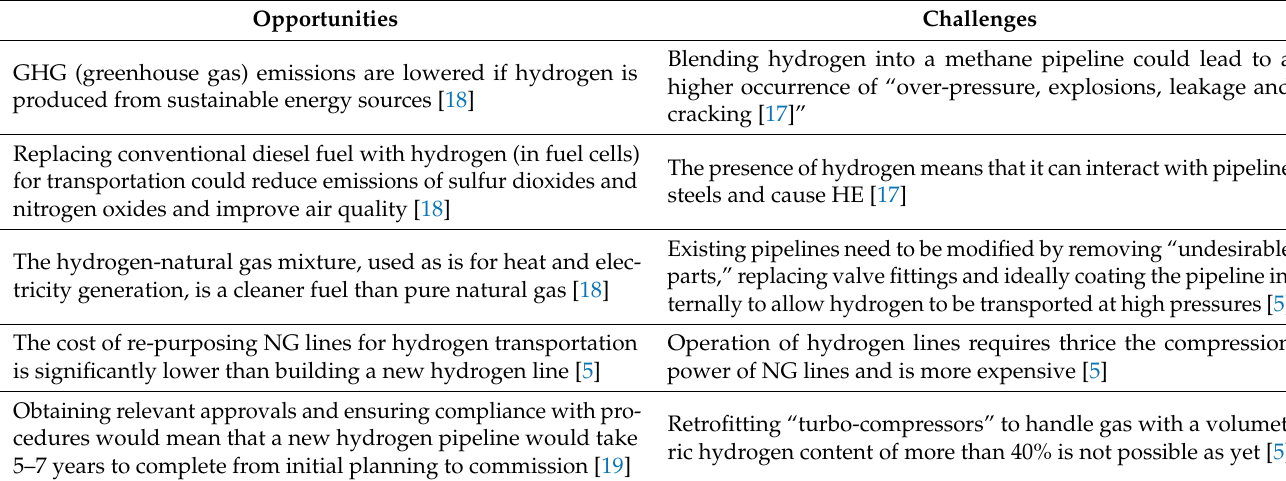
Table 3. Opportunities and Challenges of blended hydrogen